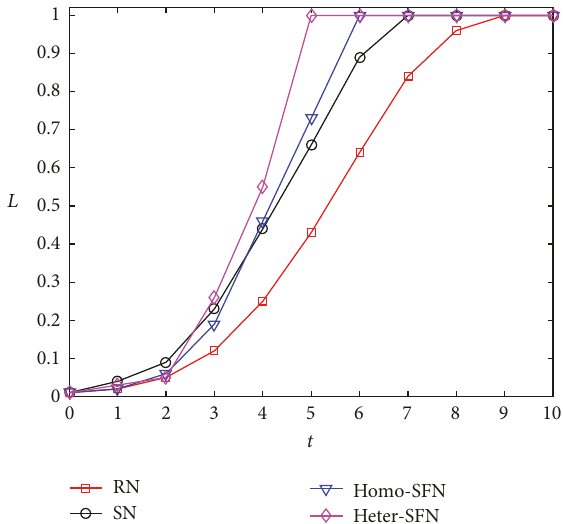
Figure 7: 𝐿 - 𝑅 relation curve under max-status attack (𝜀 = 0.6) . Figure 8: Cascading process under random attack